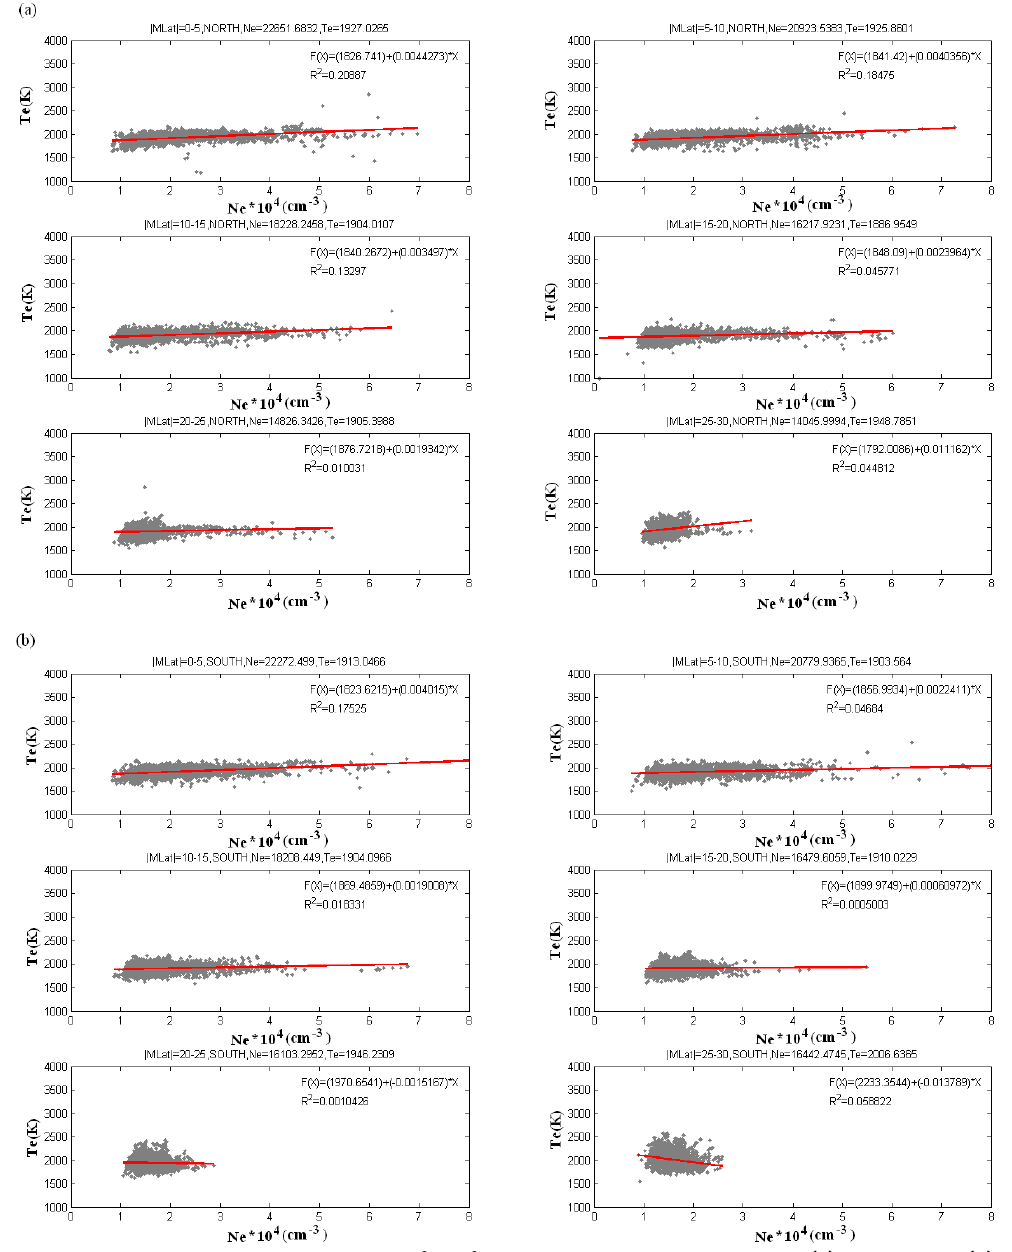
Figure 2. The linear correlation between N e and T e at 0–30 ◦ at 5 ◦ latitude intervals over the Southern (a) and Northern (b) Hemisphere (at the top of each panel, MLat represents the magnetic latitude scale, NORTH/SOUTH means Northern or Southern Hemisphere, and N e and T e are the averaged values of all the points distributed in that latitude range; the equation in each panel represents the fitted results, in which x represents N e , f (x) is T e and R is the linear correlation coefficient of N e and T e